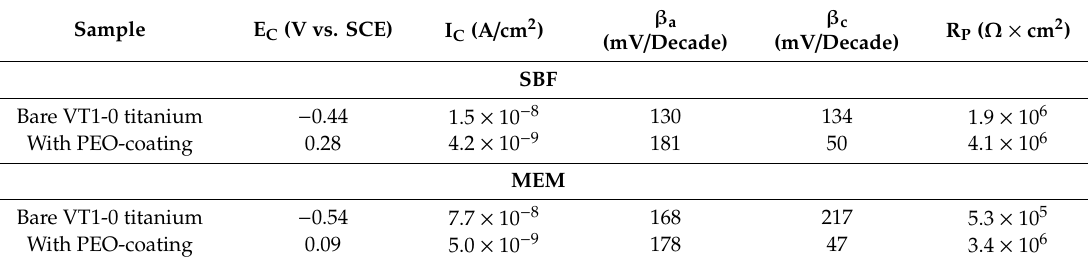
Table 5. Calculated parameters of equivalent electrical circuits for samples with different types of surface treatment.